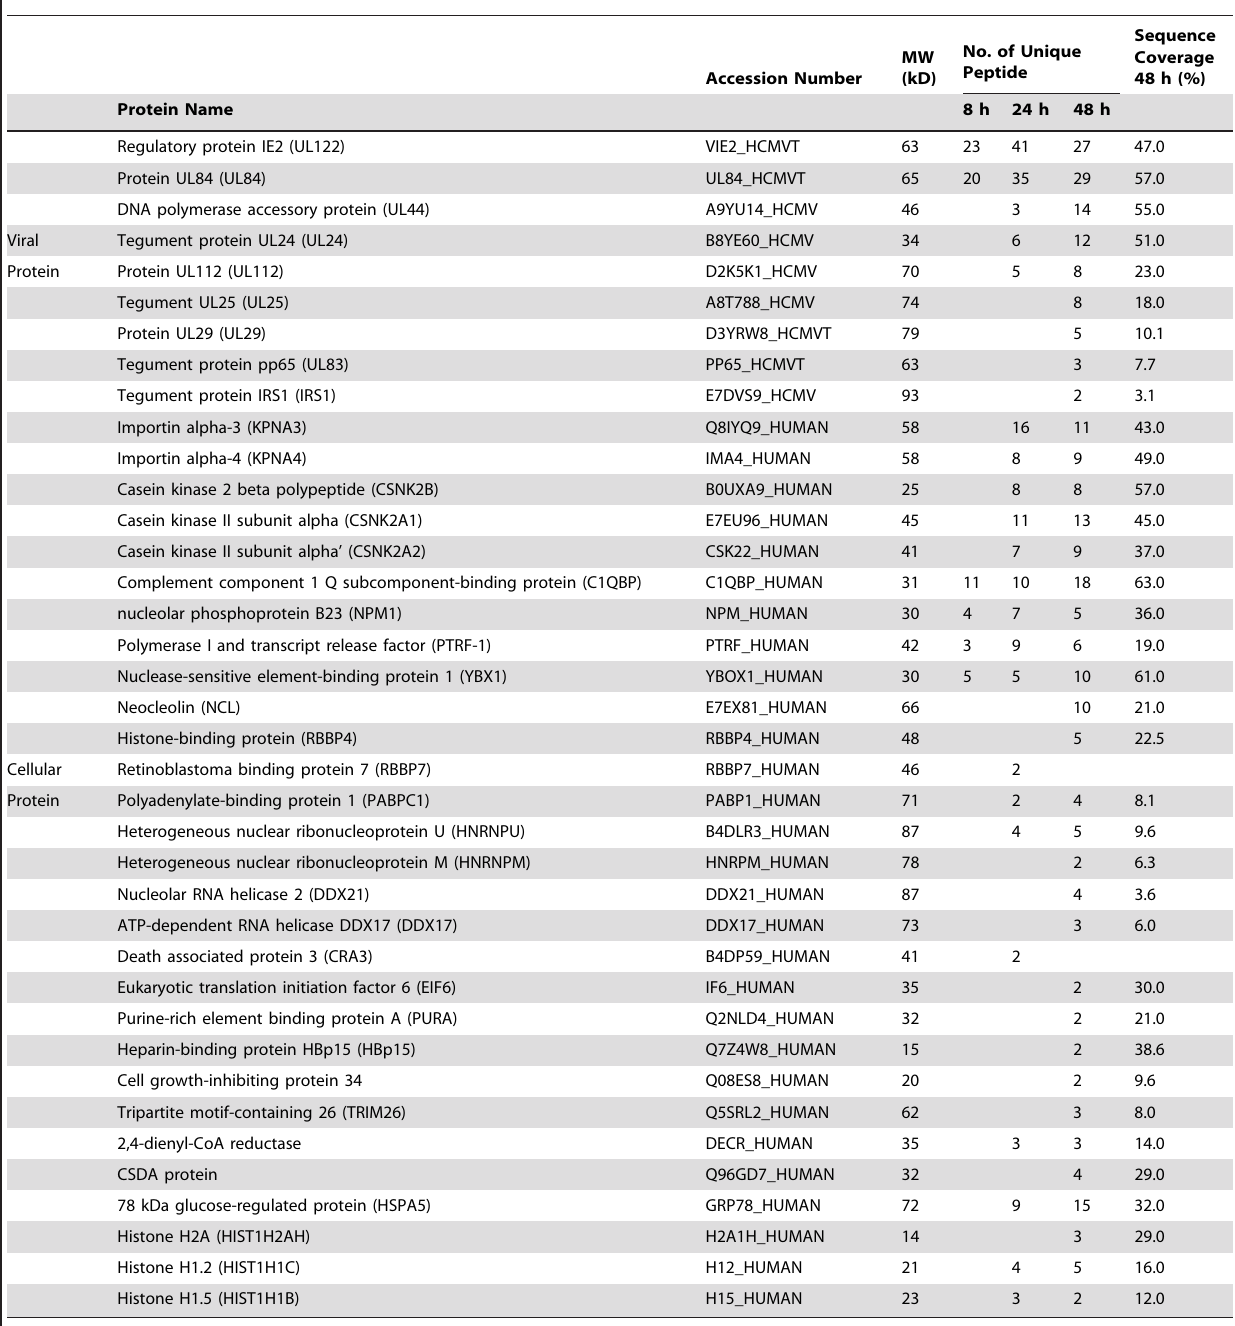
Table 2. Proteins identified from MS/MS analysis of IE2-p86SG associated